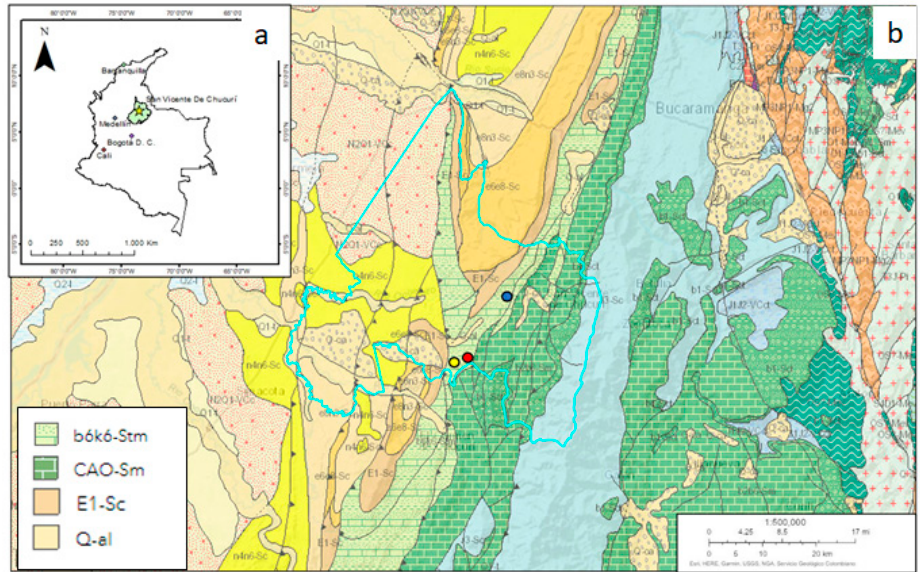
Figure 2. Maps of the study area. ( a ) Map of Colombia with the country’s main cities shown. The department of Santander is highlighted in green with a star indicating the location of San Vicente de Chucurí. ( b ) Geological map of San Vicente de Chucurí [29,30] with the municipality limits indicated by the light blue line. Sample collection sites Farm 1 (red dot), Farm 2 (yellow dot) and Farm 3 (blue dot) are indicated.